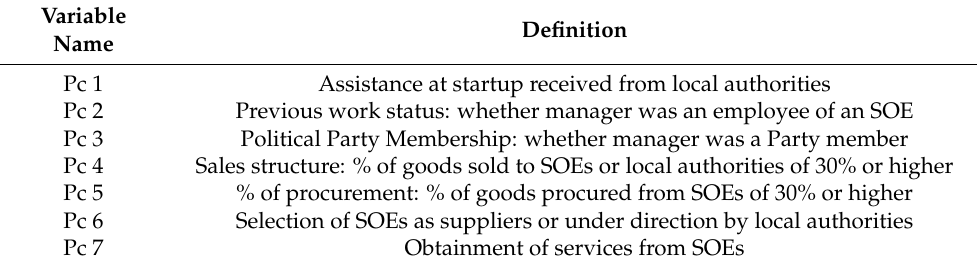
Table 4. Binary Variables Representing Political Connectedness.